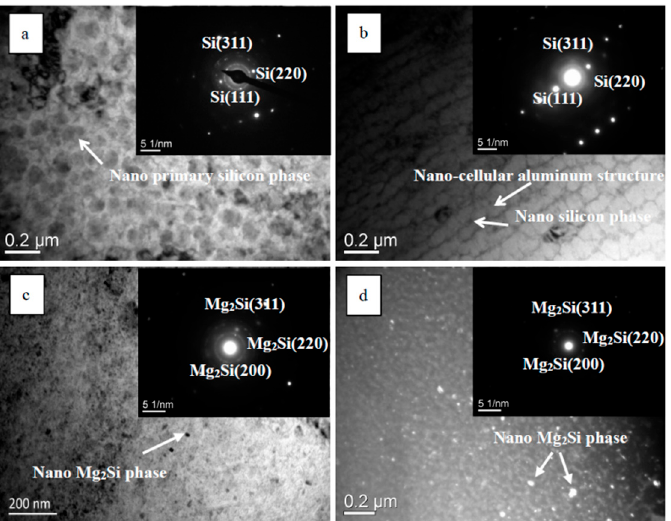
Figure 7. TEM micrographs of the Al–20Si–5Mg–0.7Ce alloy surface irradiated using HCPEB with 25 pulse treatments. ( a ) Nano-primary silicon phase; ( b ) nano-cellular aluminium structure and tiny nano-silicon phase; ( c ) nano-Mg 2 Si phase; ( d ) dark-field image of the nano-Mg 2 Si phase.